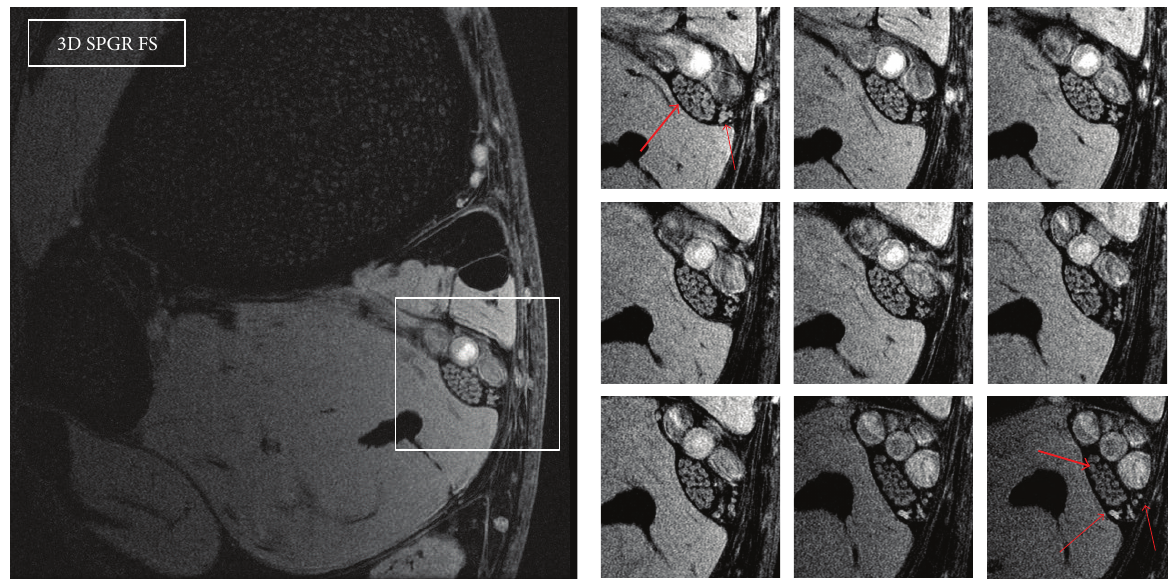
Figure 1: 3D SPGR FS, FOV 5 cm. Axial sections at the posteromedial aspect of the tibia, above the medial malleolus. The tibial nerve is visualized (large arrow) with the typical fascicular pattern. The neurovascular bundle is seen at the posteromedial aspect of the tibia. Sequential images at high resolution demonstrate the medial calcaneal nerve dividing into anterior and posterior branches, providing sensory innervation to the plantar aspect of the heel (small arrows).